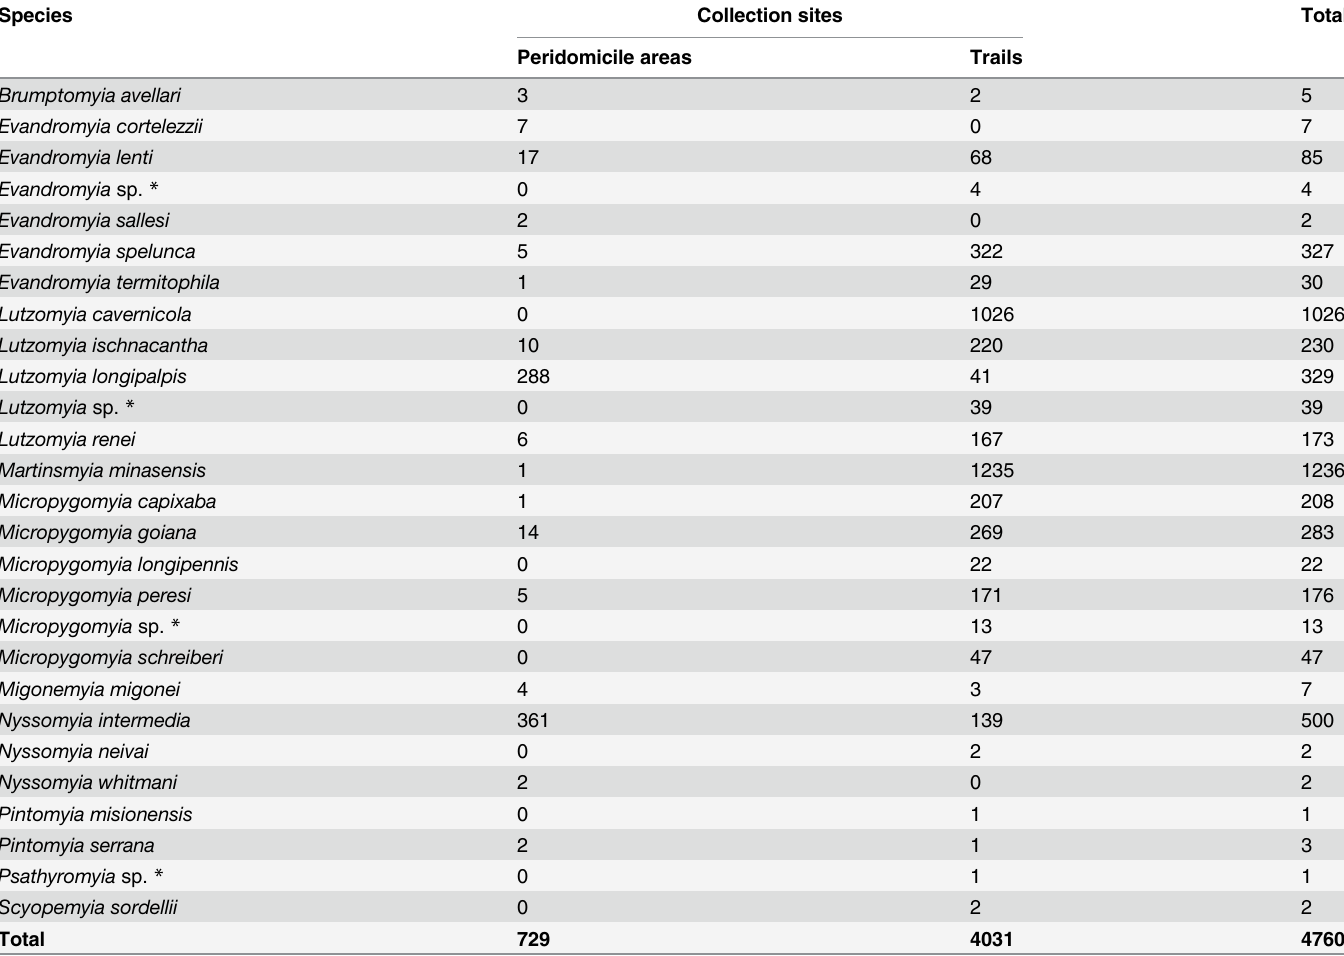
Table 1. Females of sand flies collected during the study period in the Xakriabá Indigenous Reserve, Minas Gerais, Brazil.